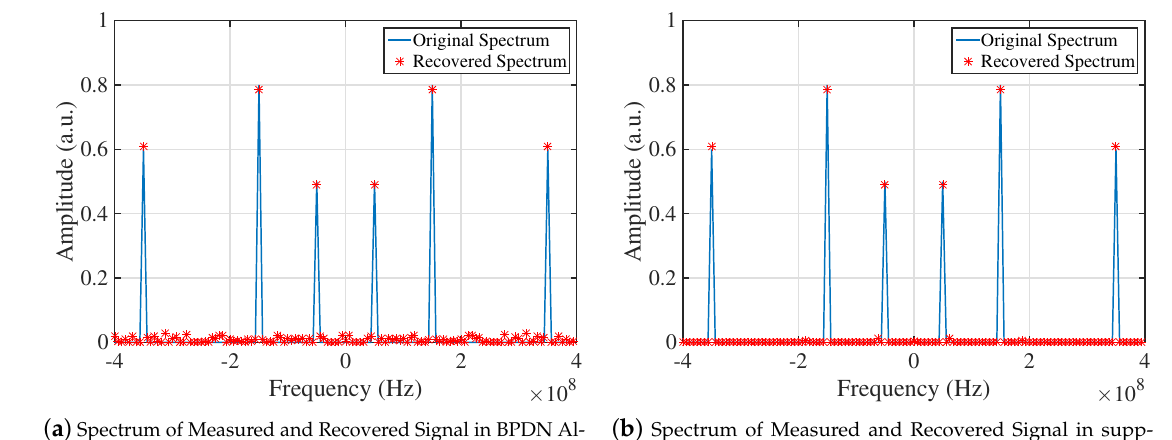
Figure 1. Spectra of original and reconstructed signals recovered by supp-BPDN and BPDN. ( a ) Reconstruction result of frequencies by BPDN. ( b ) Reconstruction result of frequencies by the proposed